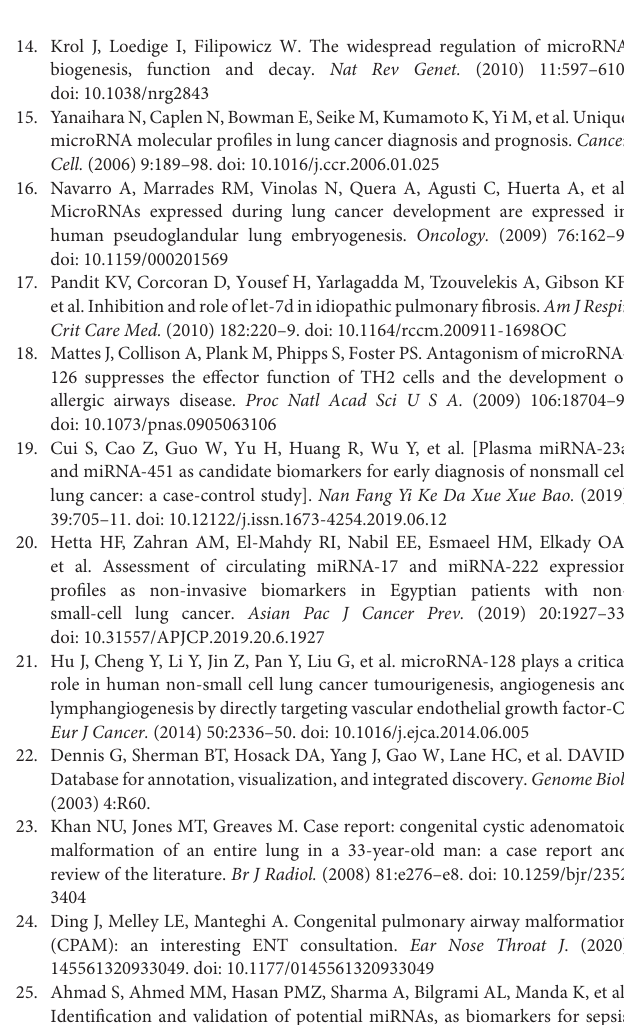
Supplementary Table 3 | The targets of up- and down-regulated miRNAs predicted by targetscan7.1 and mirdbV6. Supplementary Table 4 | GO classification of the targets for up- and downregulated miRNAs. Supplementary Table 5 | KEGG terms of the targets for up- and downregulated